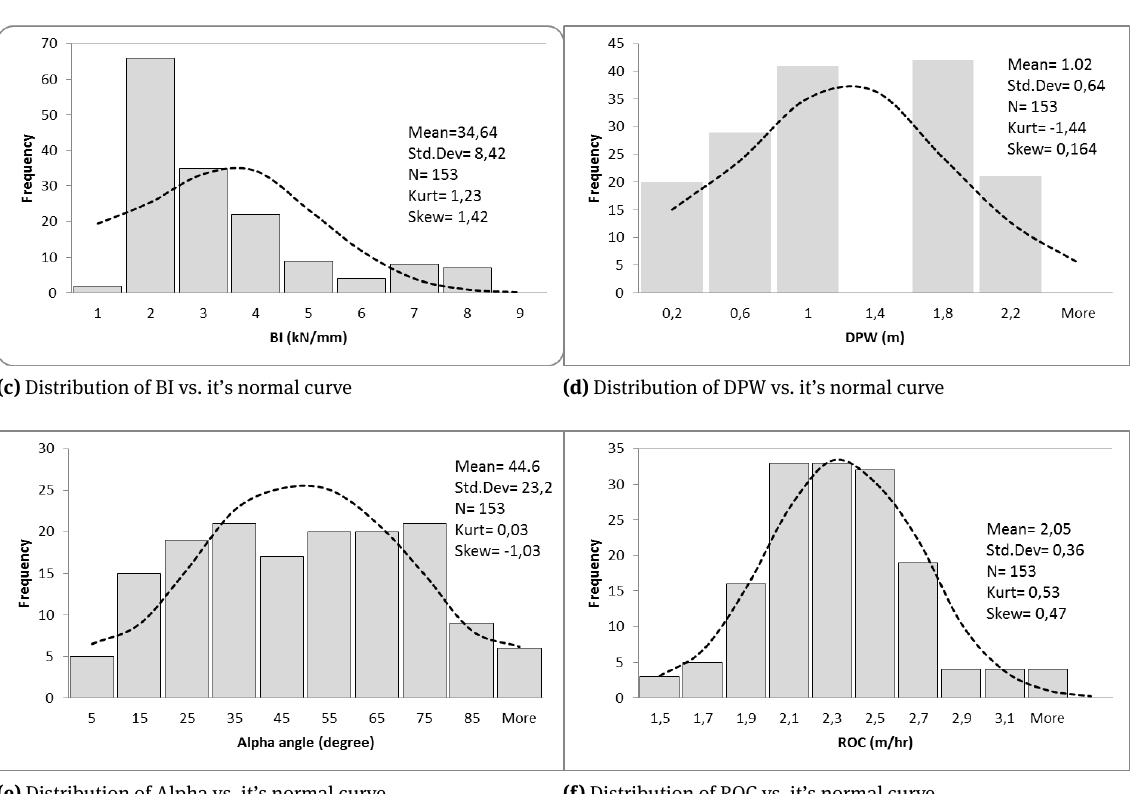
Figure 1: Distributions of database vs. their normal